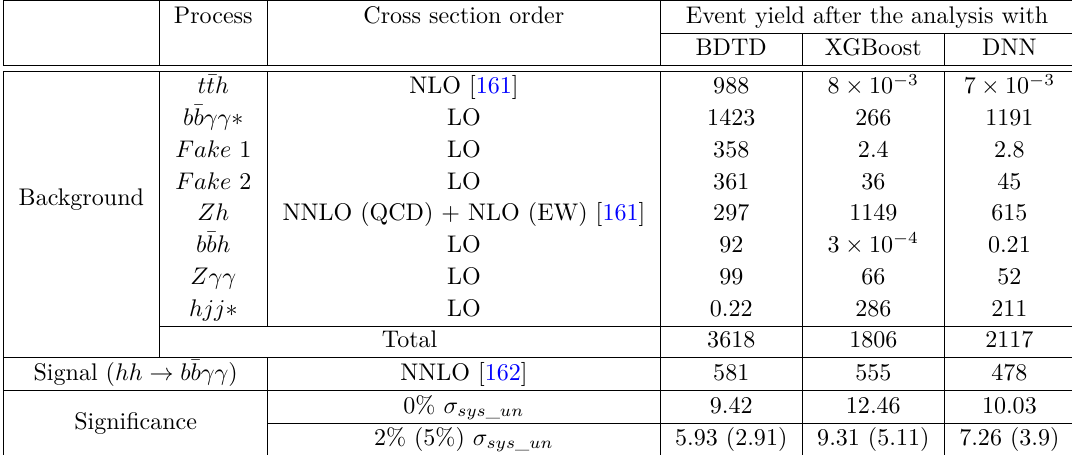
Table 2 . The signal and background yields at the HE-LHC along with the signal significance in the b ¯ bγγ channel from the analysis using BDTD, XGBoost and DNN classifiers. significance of 10 . 03 ( 3 . 9 with σ = 5% ) which is slightly lower than the sys _ un